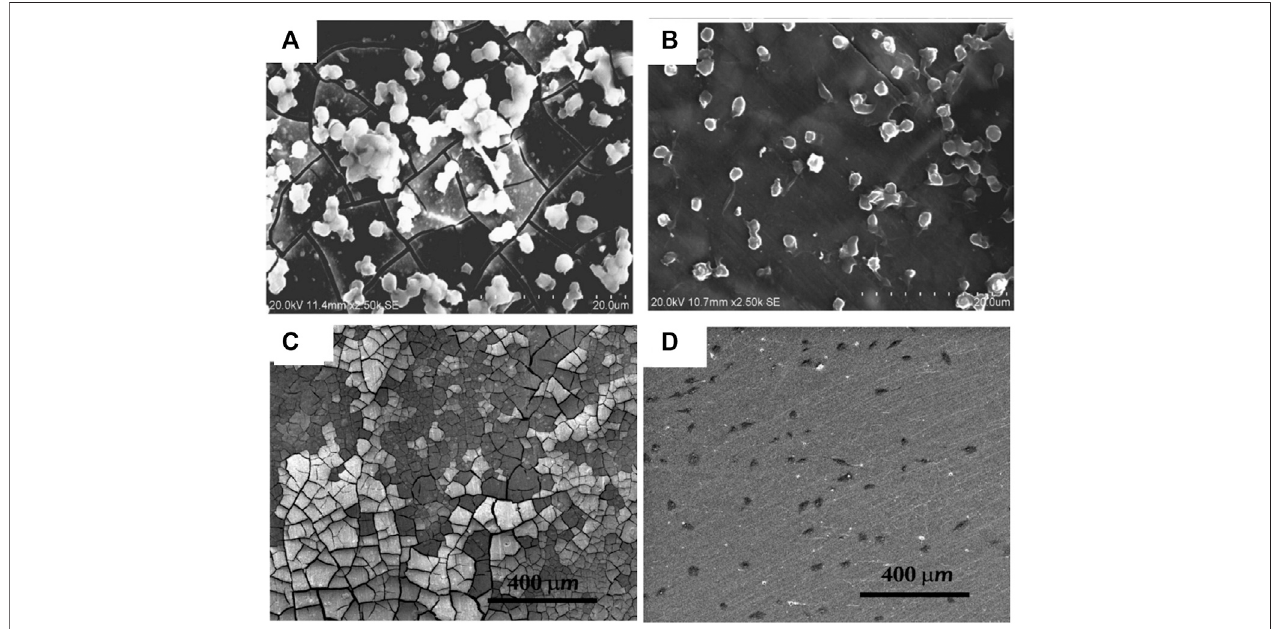
FIGURE9| Morphologyofadherentplateletsin (A) bare, (B) TiO 2 -coatedMgZn substrate, and Ea.hy926cellsculturedafter 1 day, (C) bareand (D) TiO 2 coated. Reproduced with permission from (Hou et al., 2020), MDPI.